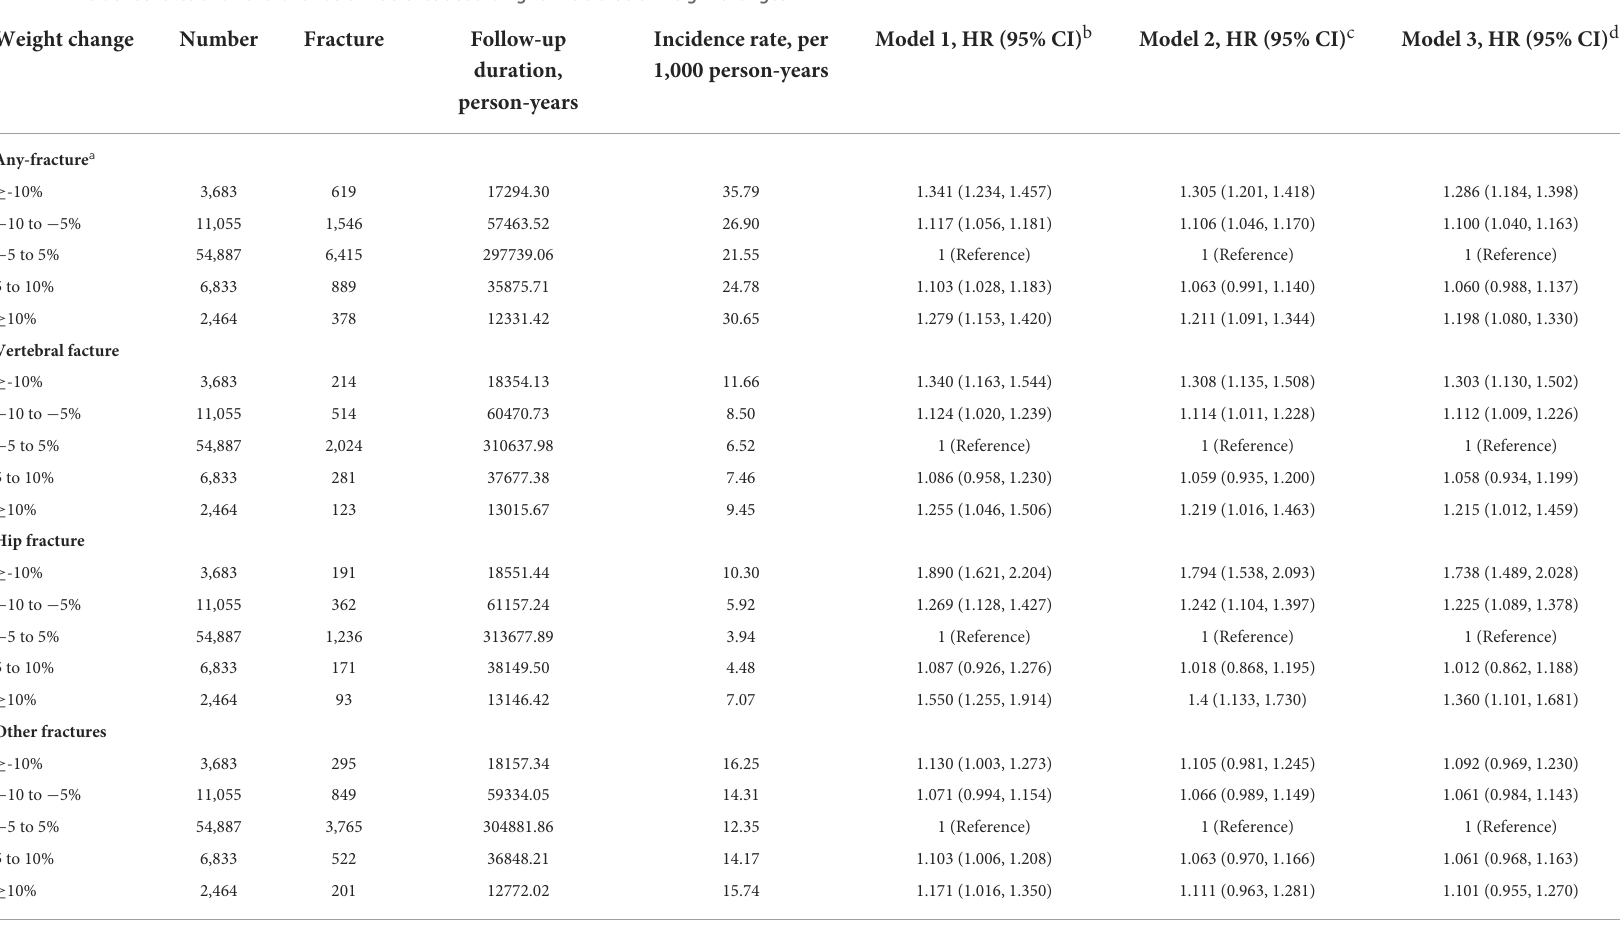
TABLE 2 Incidence rates and hazard ratios of fractures according to the status of weight